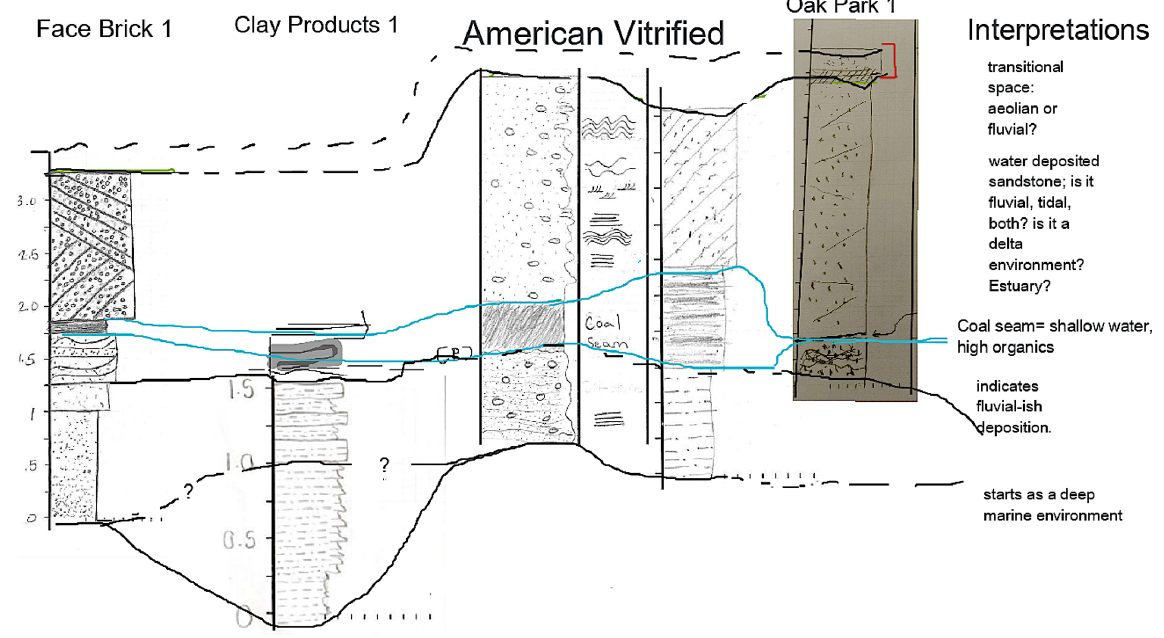
Figure 7. Example student correlation constructed in Part 7 of the assignment by one class group using Google Jamboard, including hand- drawn representative stratigraphic sections drafted in Parts